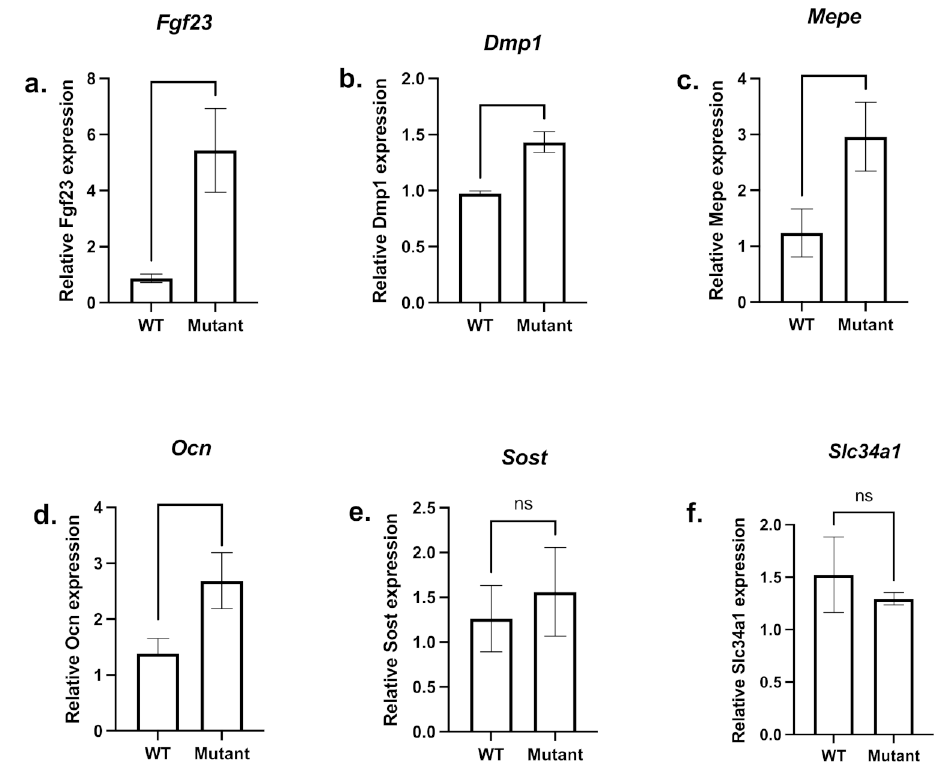
Figure 6. mRNA expression of femoral bone markers and renal type IIa sodium/phosphate co- transporter. A comparison between mutant (light grey bars) and WT (dark grey bars) femoral Fgf23 ( a ), Ocn ( d ), and Sost ( e ) mRNA expression as well as SIBLINGs Dmp1 ( b ) and Mepe ( c ) and the renal Na-Pi IIa cotransporter ( Slc34a1 ) ( f ) mRNA expression level are shown. Samples were taken from male age-matched (3 months old) mutated hemizygous ( Phex L222P /Y) and WT ( Phex /Y) males. Error bars indicate standard